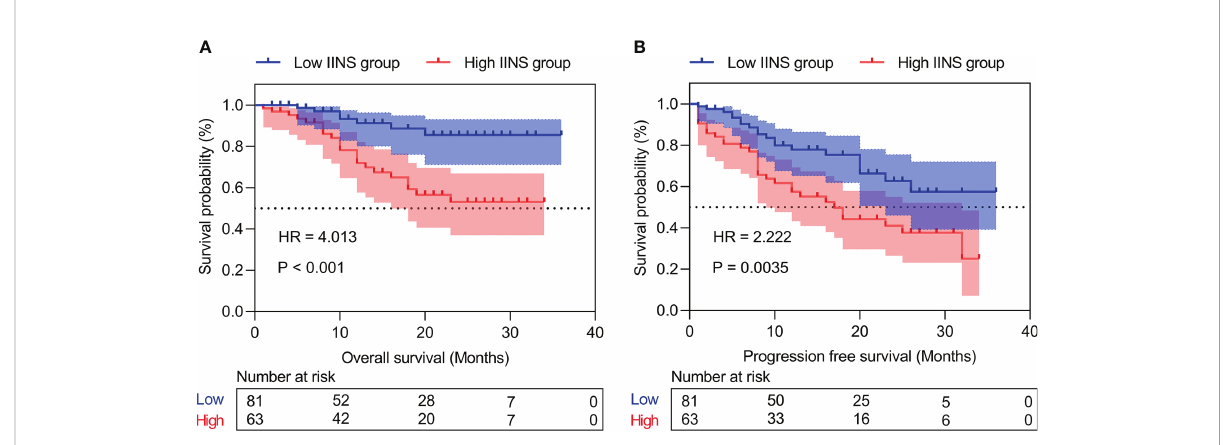
FIGURE 2 Kaplan ‐ Meier curves of in fl ammation-immunity-nutrition score (IINS) for overall survival (A) and progression-free survival (B) . IINS, in fl ammation-immunity-nutrition